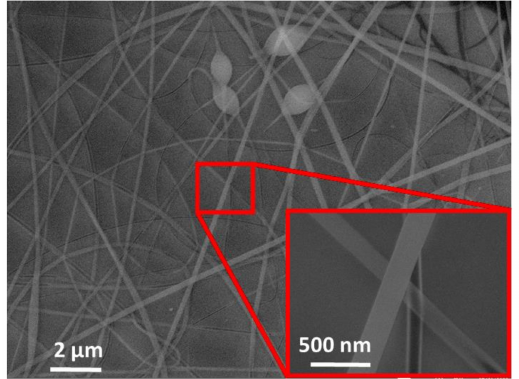
Figure 4. SEM images of the electrospun sensitive layer deposited over the transducer.